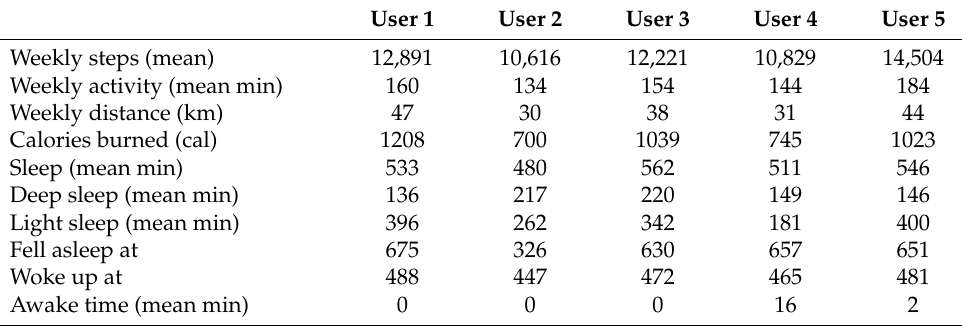
Table 2. Plain text fictional data of 5 users